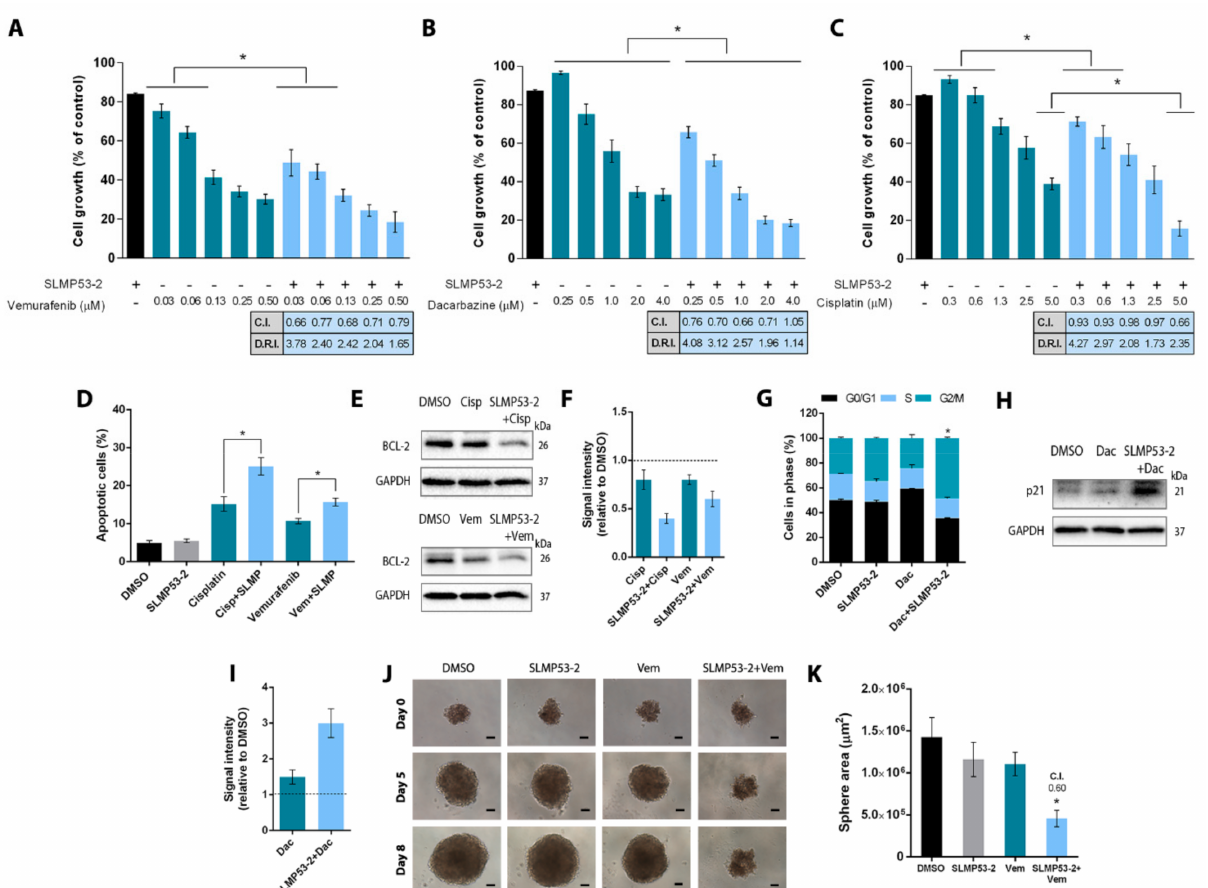
Figure 6. SLMP53-2 sensitizes melanoma cells to clinically used chemotherapeutic agents. ( A – C ) Cells were treated with a concentration range of vemurafenib ( A ), dacarbazine ( B ) and cisplatin ( C ) alone and in combination with 2 µ M SLMP53-2, for 48 h, and the growth was analysed by SBR assay. Growth with DMSO was set as 100%. For each combination, the combination index (C.I.) and dose reduction index (D.R.I.) values were obtained. Data are mean ± SEM, n = 5 (two replicates each); values are significantly different from chemotherapeutic drug alone: * p < 0.05; two-way ANOVA followed by Sidak’s test. ( D ) Apoptosis (Annexin V-positive cells) was evaluated in A375 cells after 48h of treatment with 2 µ M SLMP53-2 (SLMP) and 5 µ M cisplatin and 0.03 µ M vemurafenib. Data are mean ± SEM, n = 5; values are significantly different from drug alone: * p < 0.05, one-way ANOVA followed by Tukey’s test. ( E , F ) Protein expression levels of BCL-2 after 48 h of treatment of SLMP53-2 with cisplatin (cisp) and with vemurafenib (vem). Immunoblots are representative of five independent experiments; GAPDH was used as a loading control. In F , quantification of protein expression levels; values with DMSO were set as 1; data are mean ± SEM, n = 5. ( G ) Cell cycle analysis in A375 cells was determined after 48 h of treatment with 2 µ M SLMP53-2 and 2 µ M dacarbazine (Dac). Data are mean ± SEM, n = 5; values are significantly different from drug alone: * p < 0.05, one-way ANOVA followed by Tukey’s test. ( H , I ) Protein expression levels of p21 after 48 h treatment of SLMP53-2 with dacarbazine (Dac). Immunoblots are representative of five independent experiments; GAPDH was used as a loading control. In I , quantification of protein expression levels is shown; values with DMSO were set as 1; data are mean ± SEM, n = 5. ( J , K ) Effect of 2 µ M SLMP53-2 in combination with 0.027 µ M Vemurafenib (Vem) on three-day-old A375 spheroids for up to 8 days of treatment. For the combination, the C.I. value was obtained. Images are representative of five independent experiments; scale bar = 100 µ m; magnification = 100 × . In ( K ), data are mean ± SEM, n = 5; values are significantly different from DMSO: * p < 0.05, one-way ANOVA followed by Tukey’s